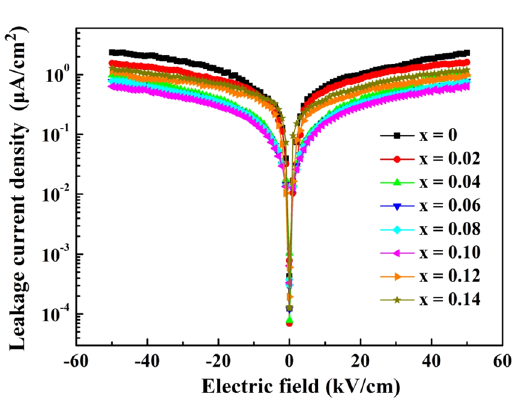
Figure 10. ( a ) P-E loops of the 0.90LLBNTZ-0.10NBN ceramic under different temperatures. ( b ) Temperature dependent energy storage density and energy storage efficiency of the 0.90LLBNTZ-0.10NBN ceramic.